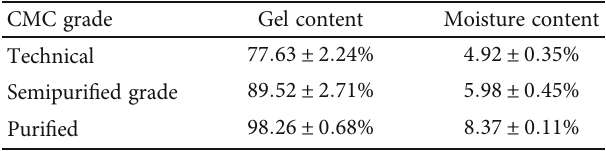
Table 3: Gel and moisture contents of di ff erent grades of CMC. CMC grade Gel content Moisture content Semipuri fi ed grade